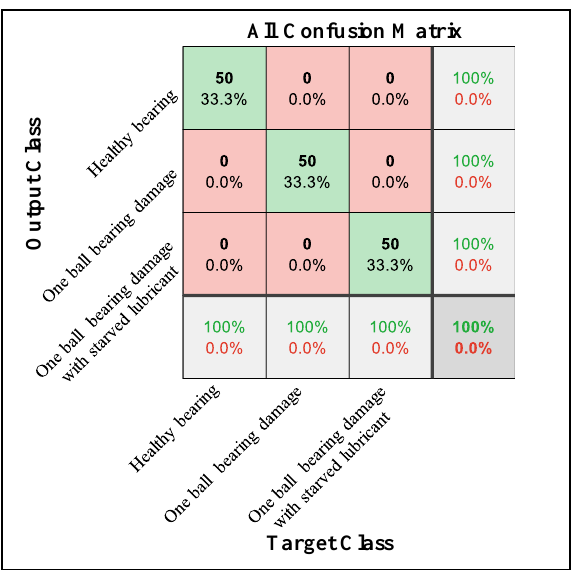
Fig . 10 Confusion